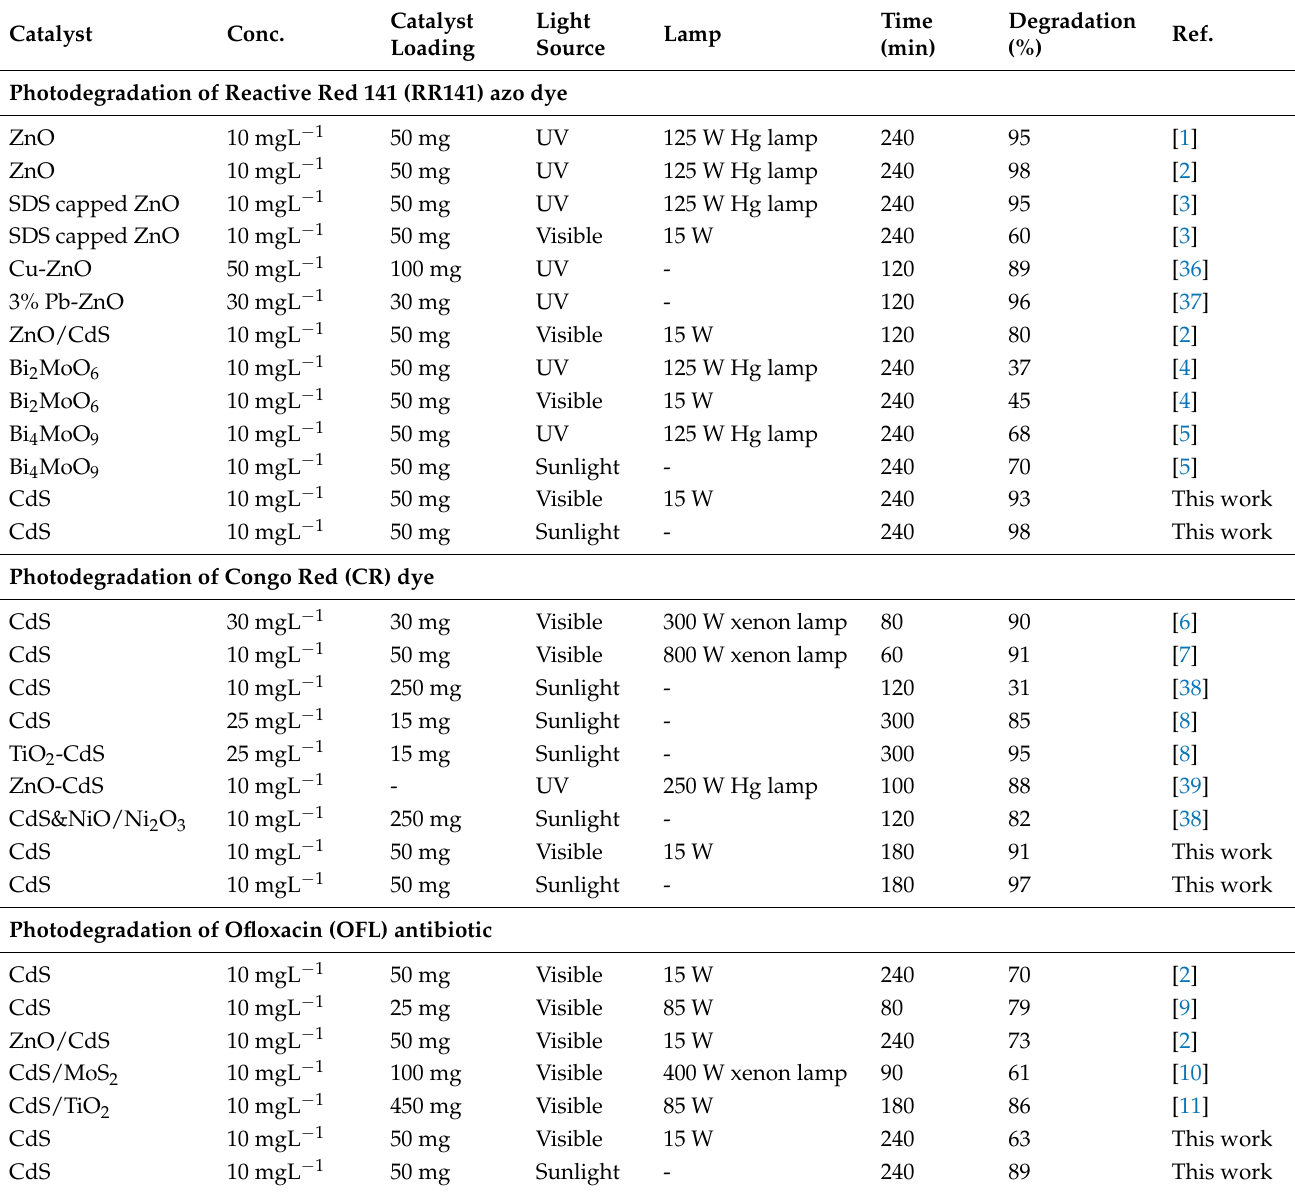
Table 1. Comparison of dyes and antibiotic degradation by using various